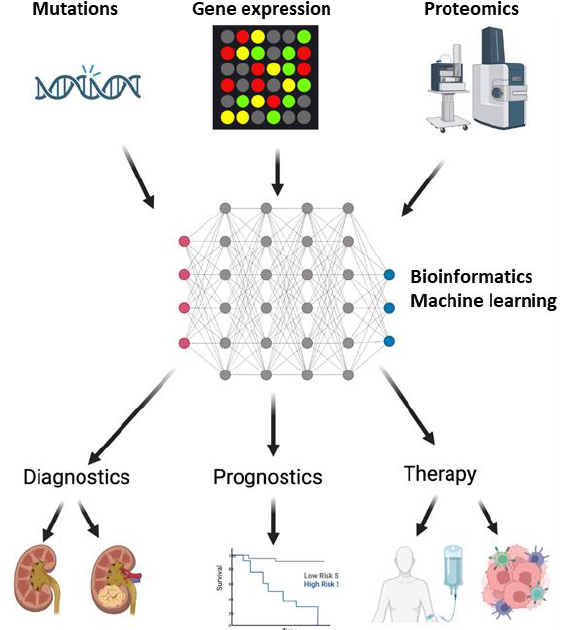
Figure 1. Implementation of biomarkers in Clear Cell Renal Carcinoma (ccRCC). DNA sequencing, microarray, and mass spectrometry with liquid chromatography identify the mutation, gene, and protein expression profiles. These profiles create big data, that, when analyzed by machine learning algorithms, can identify markers for diagnosis, prognosis, and therapeutic decisions for ccRCC. In terms of diagnosis, these biomarkers can help in distinguishing ccRCC patients from healthy individuals, as well as from other patients with benign or malignant renal masses. Disease progression and survival, as an outcome of therapy, can be monitored by prognostic biomarkers. Finally, these biomarkers can provide information, which can offer precision medicine for